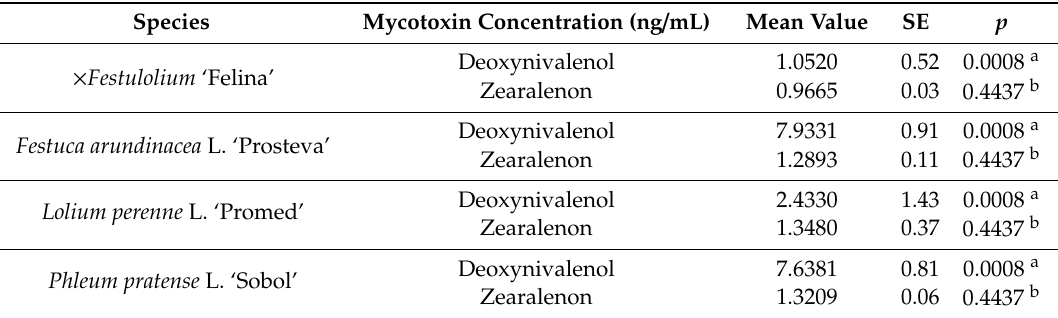
Table 5. Botanical species e ff ects on mycotoxin concentration in plant